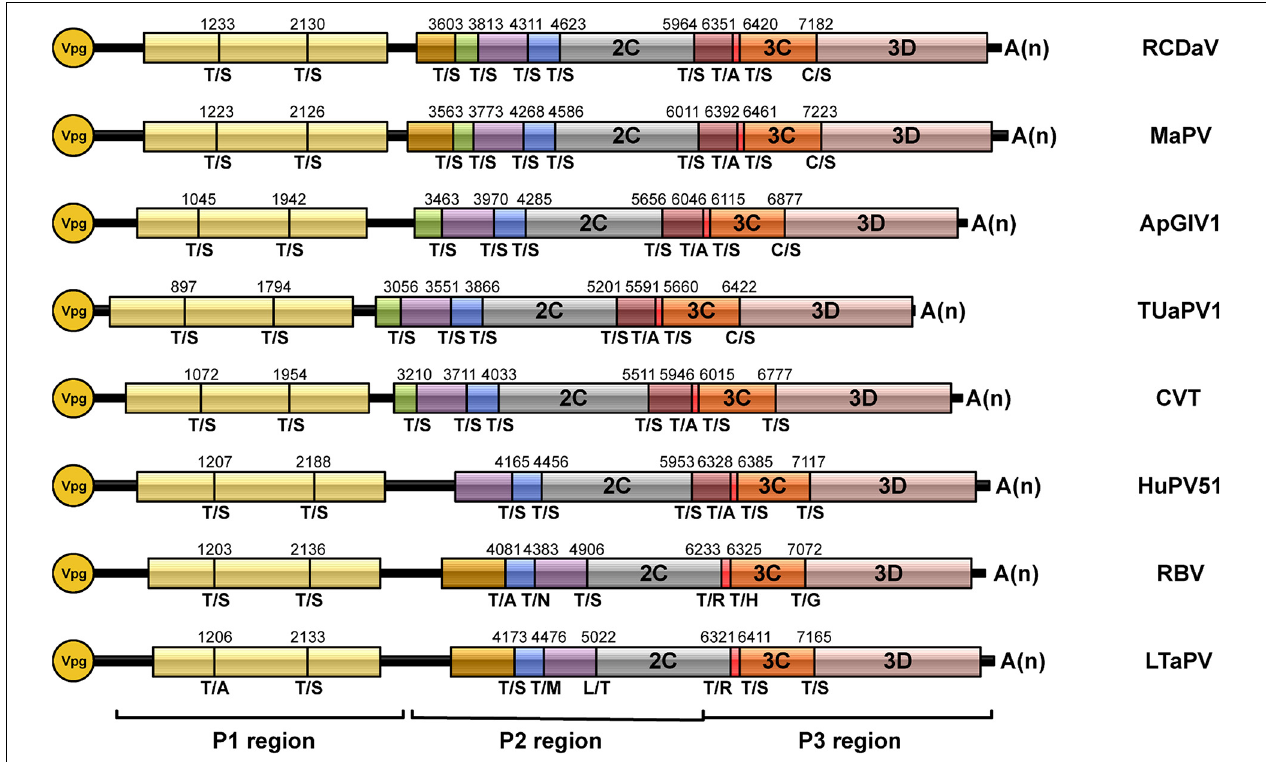
FIGURE 9 | Genome organizations of rice curl dwarf-associated picornavirus (RCDaV) and seven unclassified picornaviruses. The predicted cleavage sites are shown.